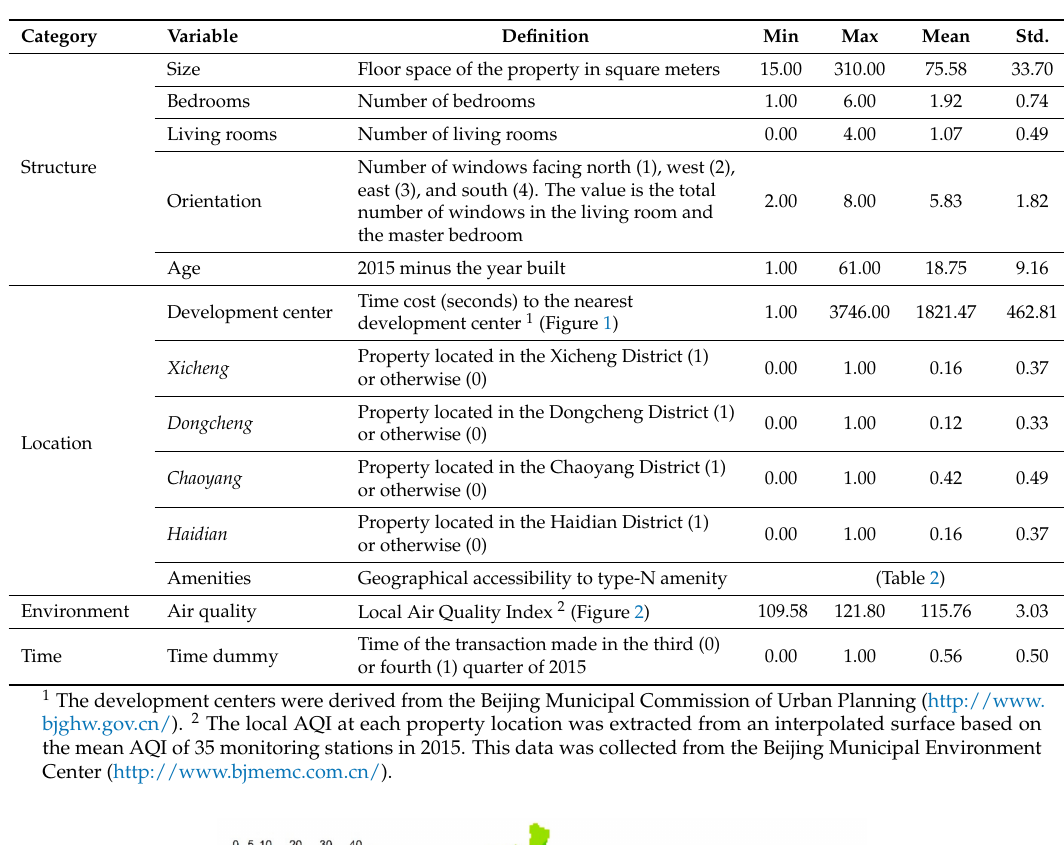
Table 1. Classification of property characteristics.